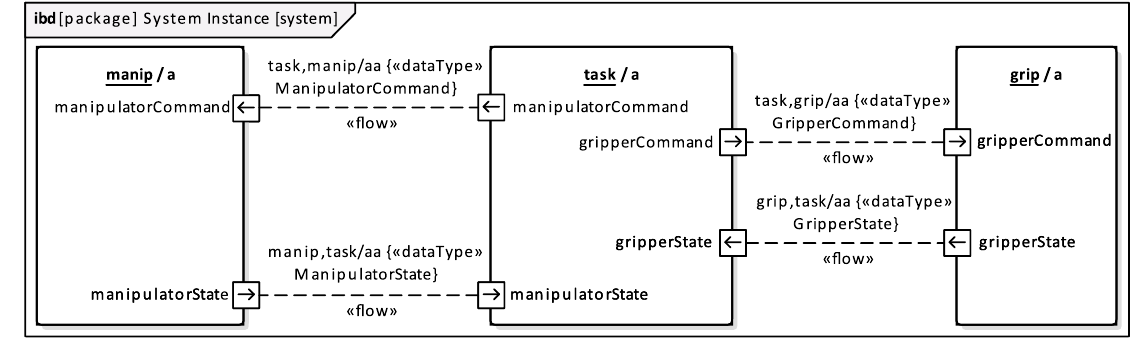
Figure 8. Structure of the considered exemplary